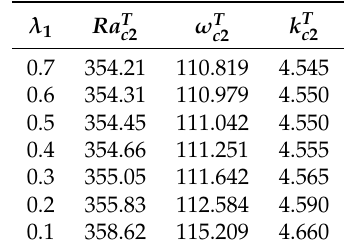
Table 2. Critical Rayleigh number Ra T transverse rolls as a secondary instability for Γ = 0.75 and different values of λ 1